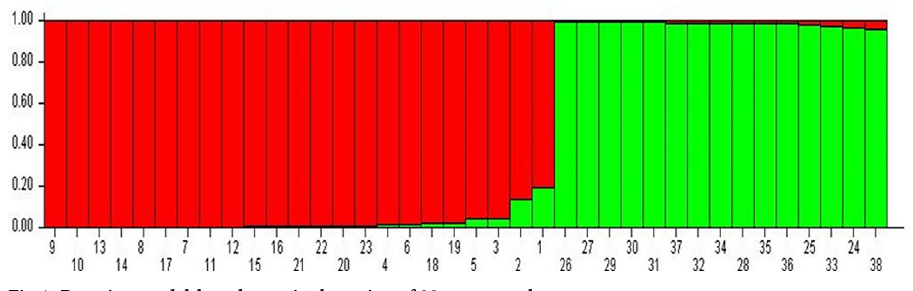
Fig 4. Bayesian model-based genetic clustering of 38 oat